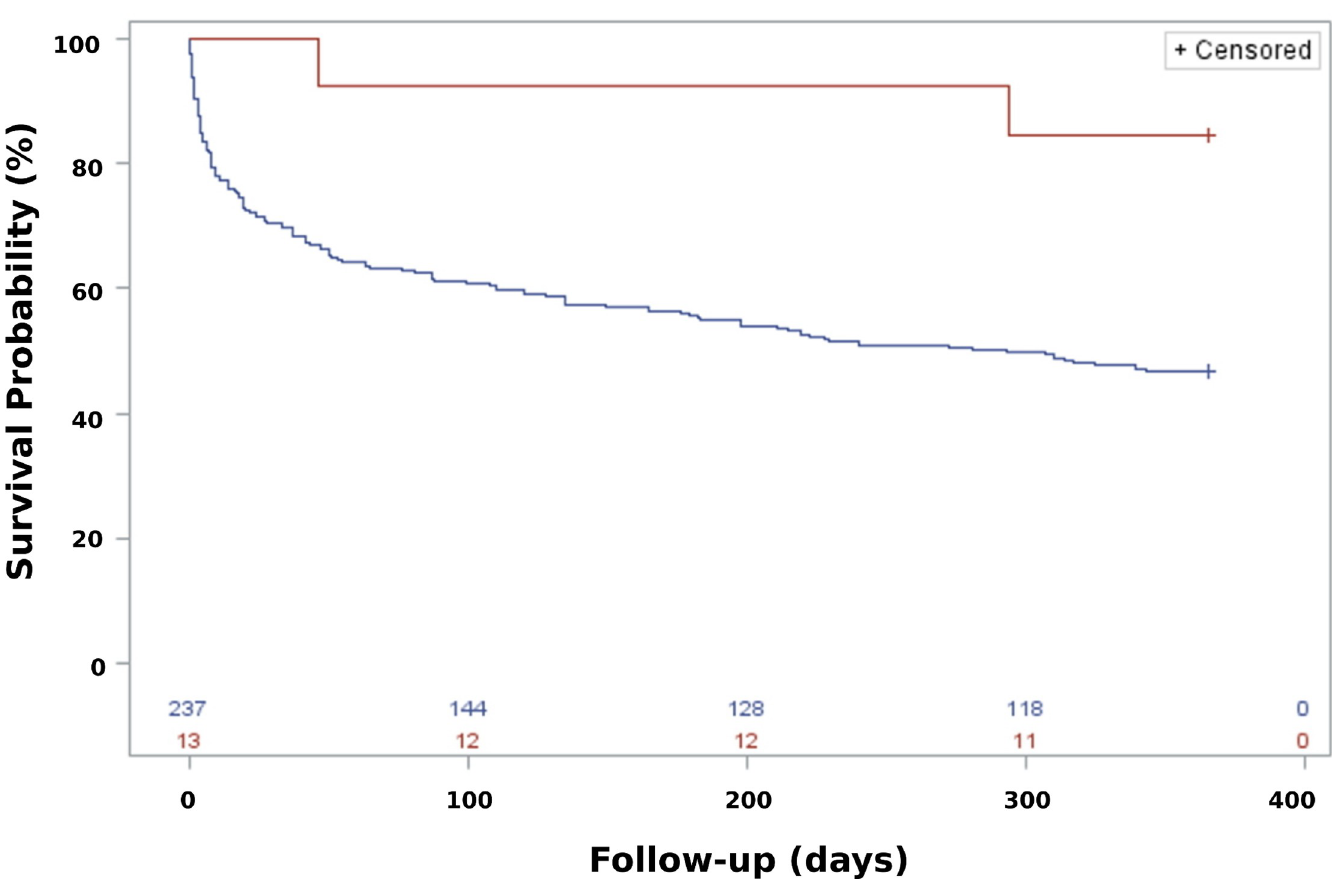
Fig 3. Unadjusted Kaplan-Meier survival estimates by treatment group in patients with pulmonary Pseudomonas aeruginosa . Red line: � 14-days dual antibiotic treatment. Blue line: all other antibiotic treatment regimes. Log-rank test: p = 0.016.